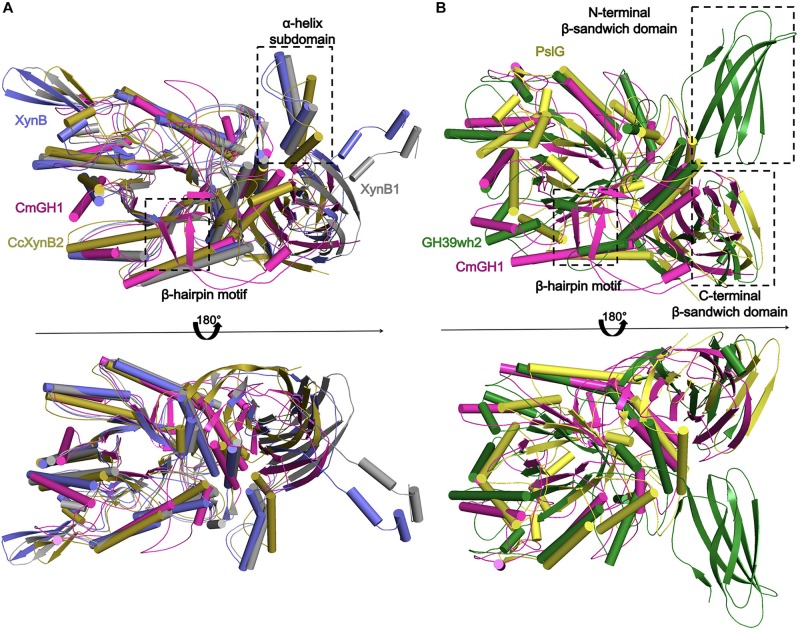
Structural comparison of CmGH1 with other homologs of GH39 family. (A) The structural superposition of CmGH1 (magenta), XynB (blue, PDB_ID: 1PX8 (Yang et al., 2004), RMSD: 5.171 Å, 206 atoms), XynB1 (gray, PDB_ID: 1W91, RMSD: 1.925 Å, 147 atoms), and CcXynB2 [dark yellow, PDB_ID: 4EKJ (Santos et al., 2012), RMSD: 9.550 Å, 236 atoms]. (B) The structural superposition of CmGH1 (magenta), GH39wh2 [green, PDB_ID: 5JVK (Ali-Ahmad et al., 2017), RMSD: 10.275, 263 atoms], and PslG [yellow, PDB_ID: 4ZN2 (Yu et al., 2015), RMSD: 11.294, 240 atoms].